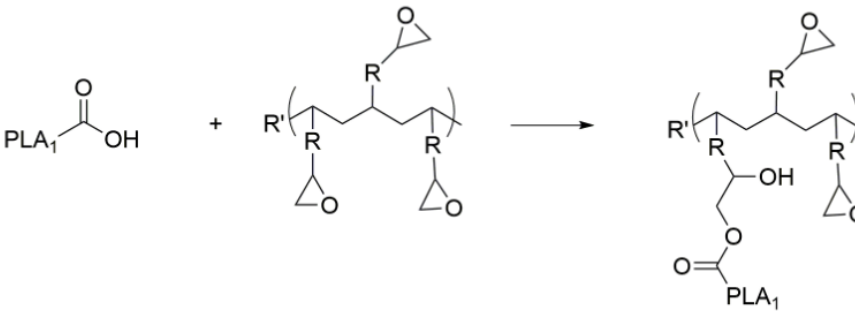
Figure 2. Possible reaction between PLA and the PCDI [55].